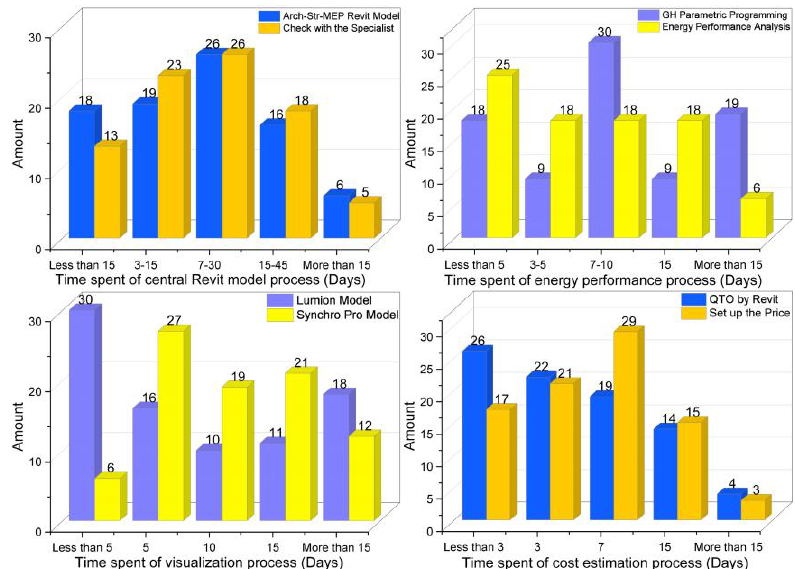
Figure 6. Questionnaire feedback on BIM-assisted workflow.